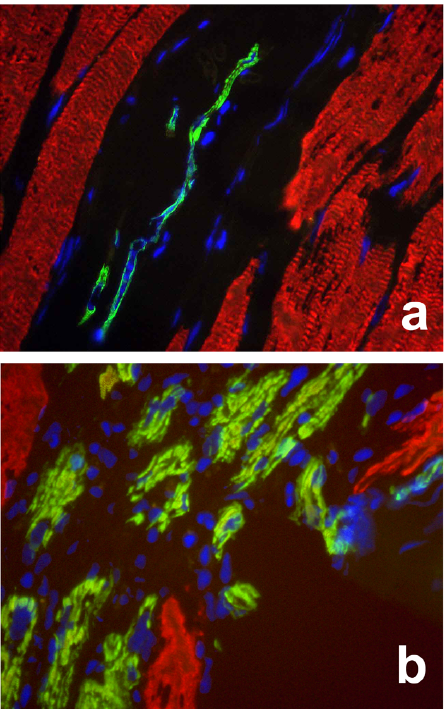
Supplemental Figure 2. Enlargement of Figure 2Af ( a ) and Figure 3Ai ( b ), showing that, either in normal adult muscle ( a ), or at 4d post- injury during the healing process ( b ), regenerating α CAA (green) positive myofibers with centrally located nuclei (blue) are detectable. Differentiated muscles express α SKA (red) with peripheral located nuclei (blue) in both